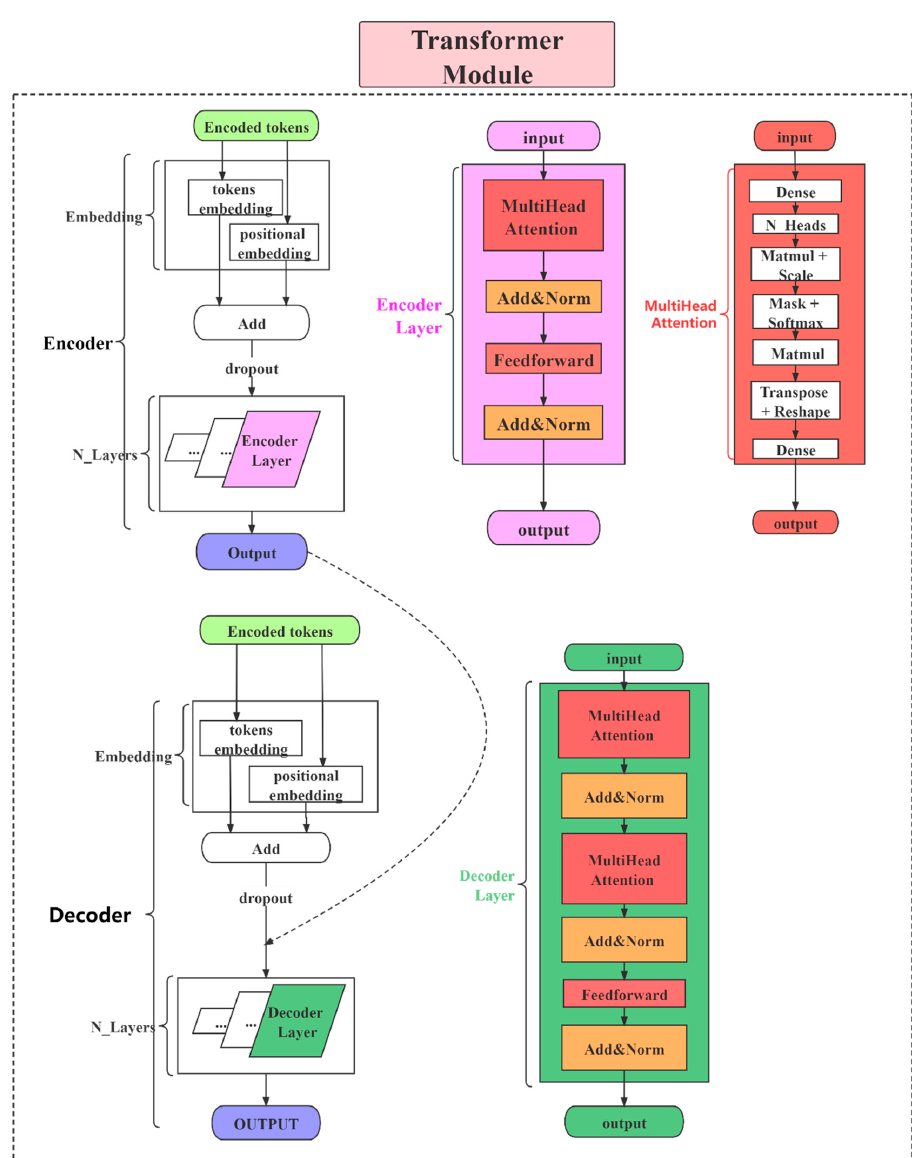
Figure 4. The transformer architecture in our model.